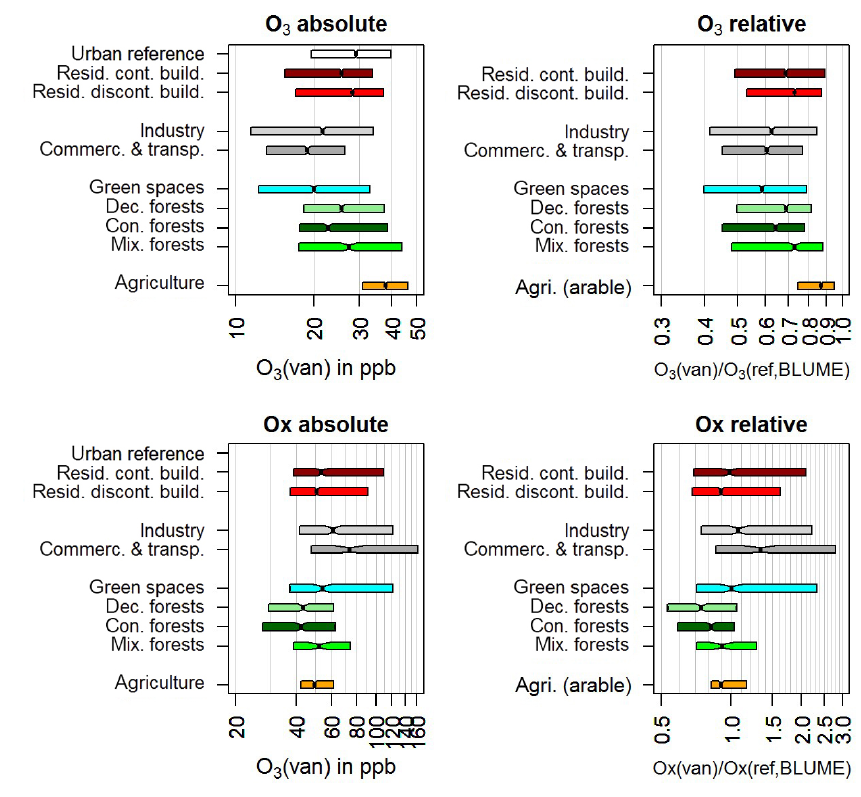
Figure 9. Box plots of mobile measurements (left) and relative (right) values box plots for ozone (top) and Ox (bottom) with respect to different surface type usage based on CORINE. Box plots range from the 25th to the 75th percentile each with notches from the 45th to the 55th percentile centered around the median. Shaded bars indicate an insufficient number of data points. Values and the corresponding numbers of available data are provided in